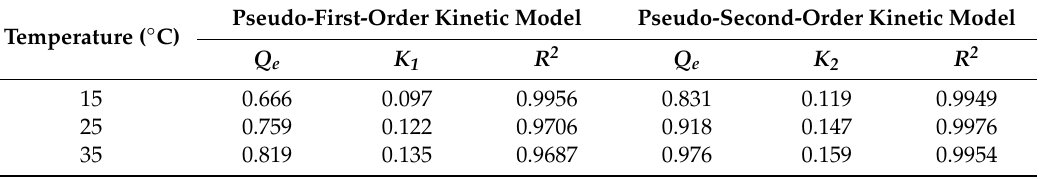
Figure 5. Adsorption kinetic curve of ZSFB composite fiber at different temperatures. Table 4. Kinetics of phosphorus removal by ZSFB composite fiber at di ff erent temperatures. Temperature ( ◦